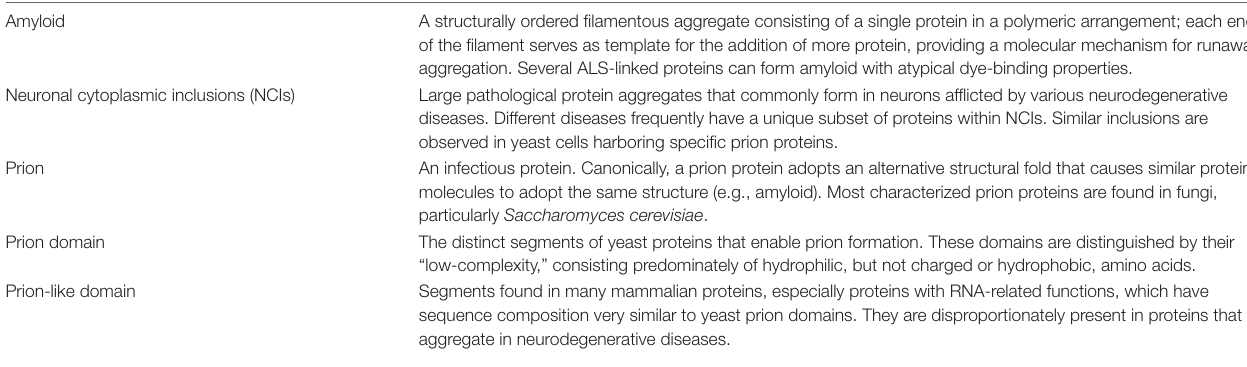
TABLE 1 | Concepts linking yeast prions and subtypes of amyotrophic lateral sclerosis (ALS) and frontotemporal dementia (FTD).